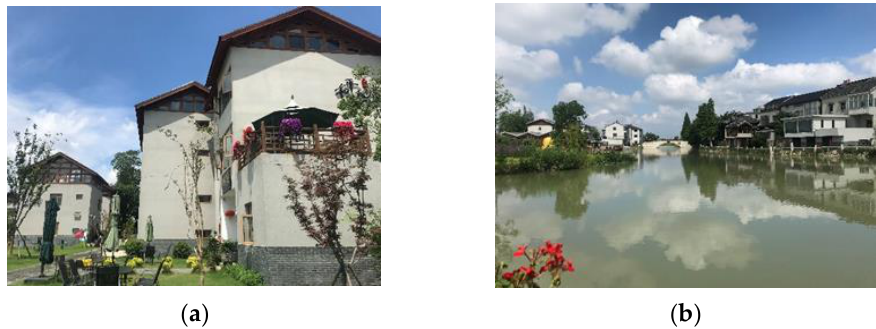
Figure 7. Current situation of Qianjiadu village construction: ( a ) renovated and constructed residen- tial quarters; and ( b ) beautiful scenery in Qianjiadu village.